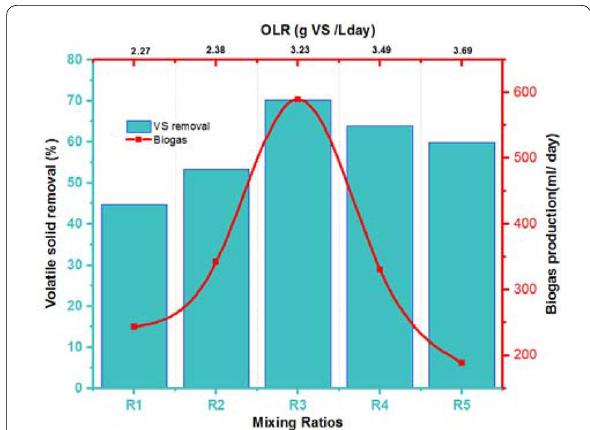
Fig. 5 Average biogas and methane production rate versus volatile solids’ reduction